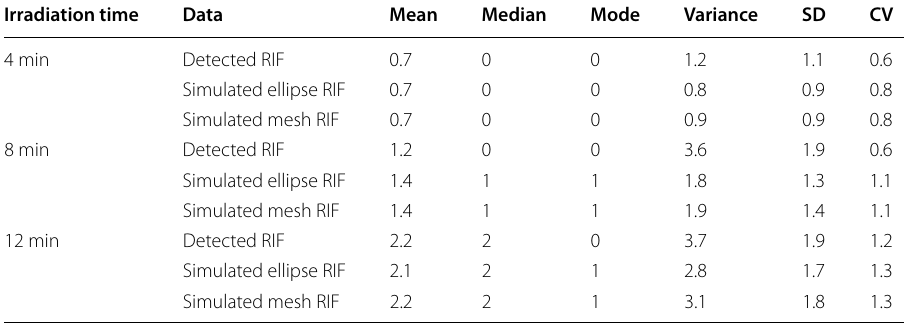
Table 1 Summarized properties of the detected RIF distribution, and the simulated RIF distributions from the elliptical cylinder phantom and the mesh volume phantom Irradiation time Data